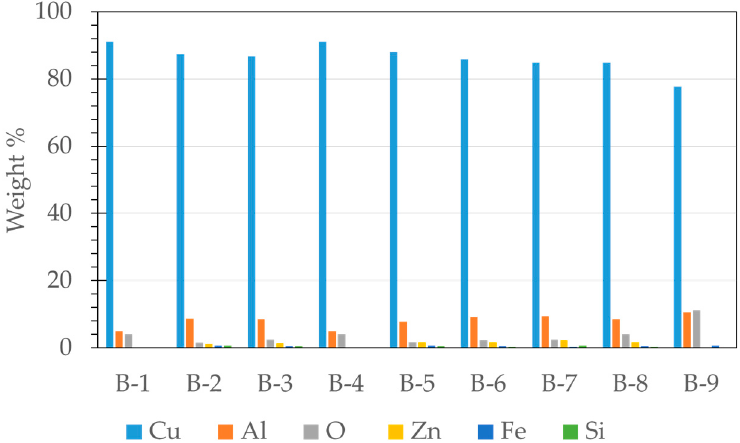
Figure 2. Chemical composition of coatings. Weight percentage determined by EDS Analysis.